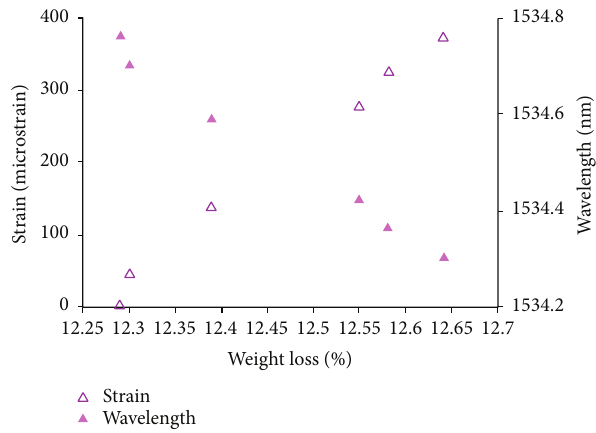
Figure 3: Bragg wavelength shift due to drying of gel.